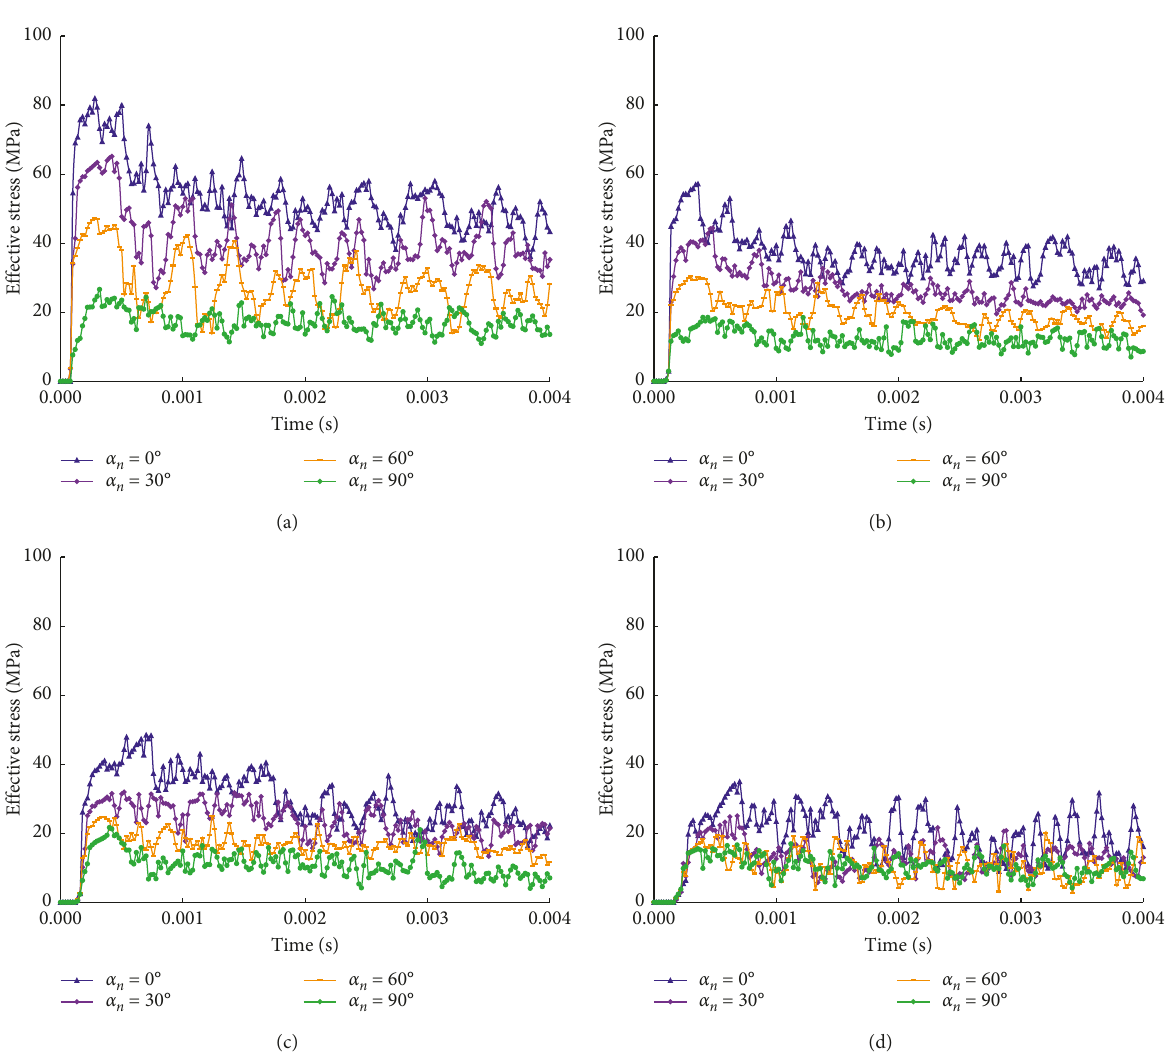
� 8. (b) D � 12. (c) D � 16. (d) D m / r b m / r b m / r b m /